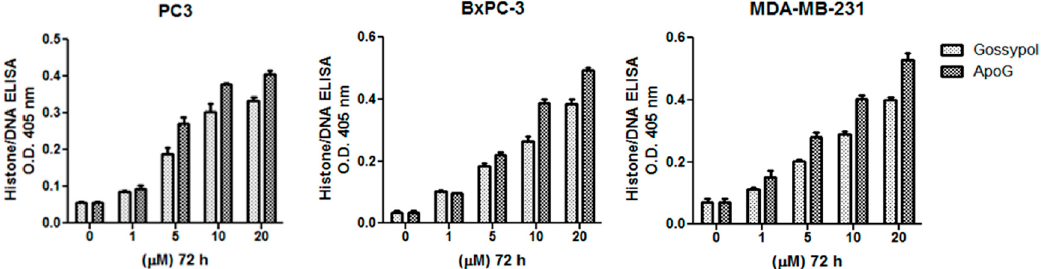
Figure 2. The Cell Death Detection ELISA Kit (Roche, Palo Alto, CA, USA) was used to detect apoptosis in MDA-MB-231, BxPC3 and PC3 cancer cell lines. Cells were treated with increasing concentrations of gossypol and ApoG2, as indicated, and processed as described in the Materials and Methods. Values reported are ±SEM of three independent experiments.